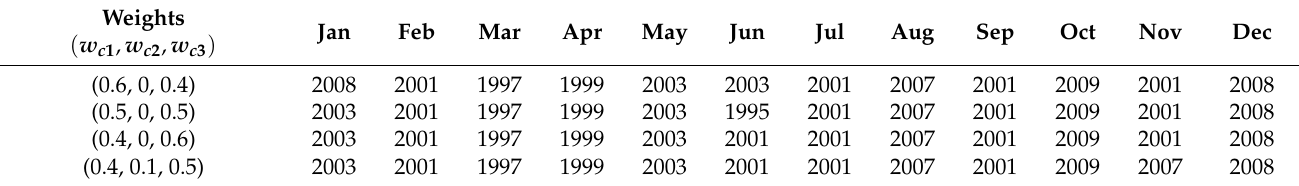
Table 3. The representative met-ocean reference years identified by four different combinations of component weighting factors.